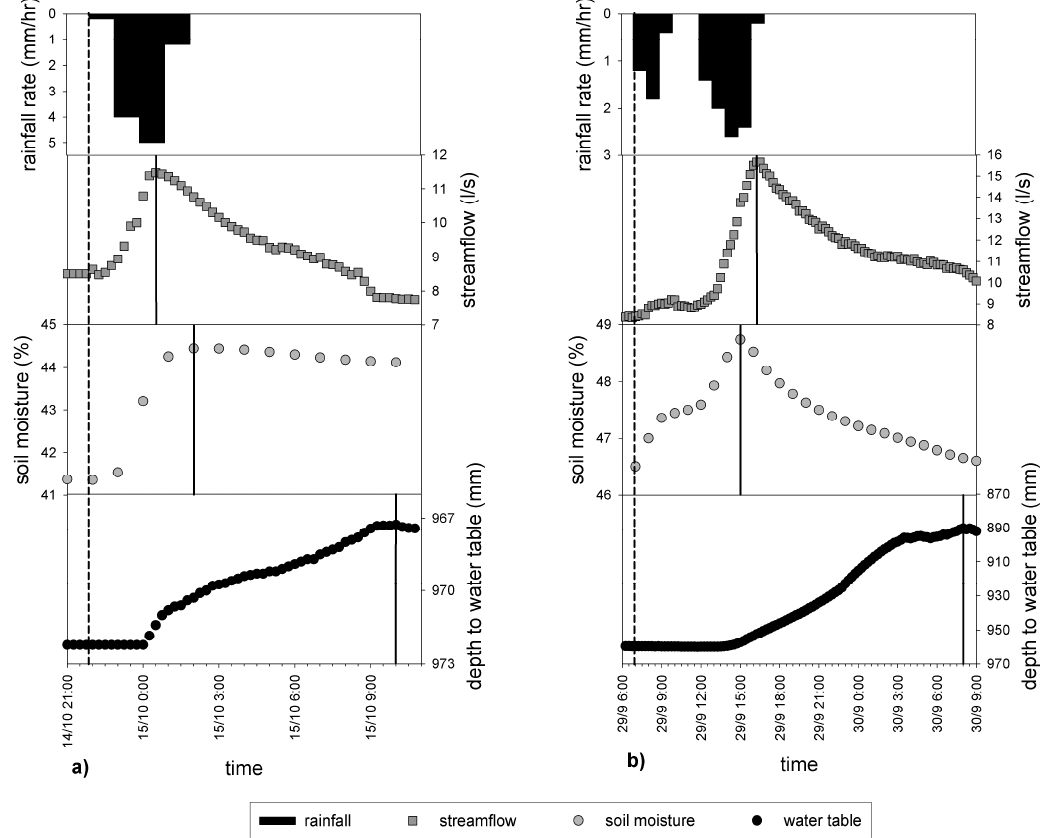
Figure 7. Time series of streamflow, soil moisture and water table for a) an event with dry antecedent conditions (14 Oct. 2006, 10.4 mm) and b) an event with wet antecedent conditions (29 Sept. 2005, 12.0 mm) Note the difference in scale of the axes. The vertical dashed line represents the time of the start of the rainfall event. The vertical solid lines represent the time of the peak of the response.